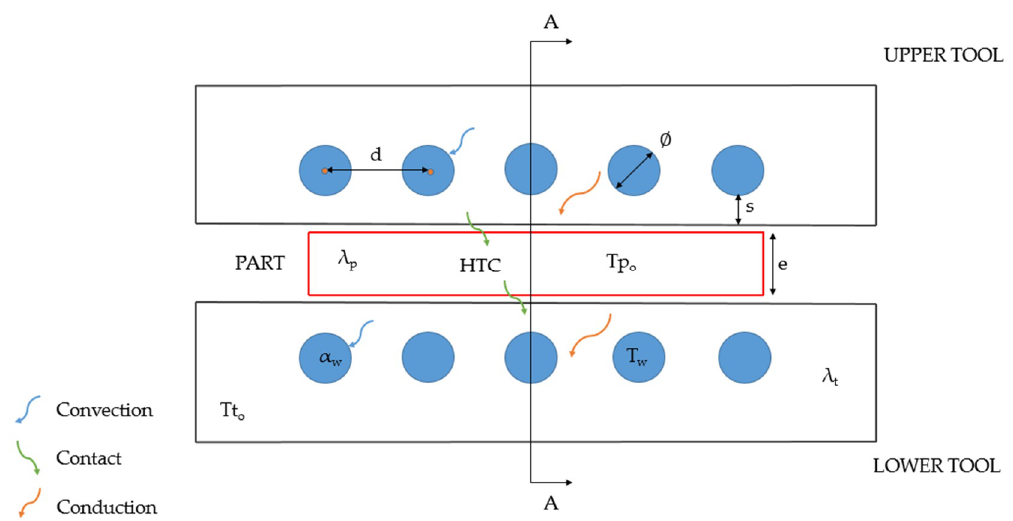
Figure 1. Scheme of a hot stamping tool with an upper cooled tool, a lower cooled tool, and a hot stamped part in between.